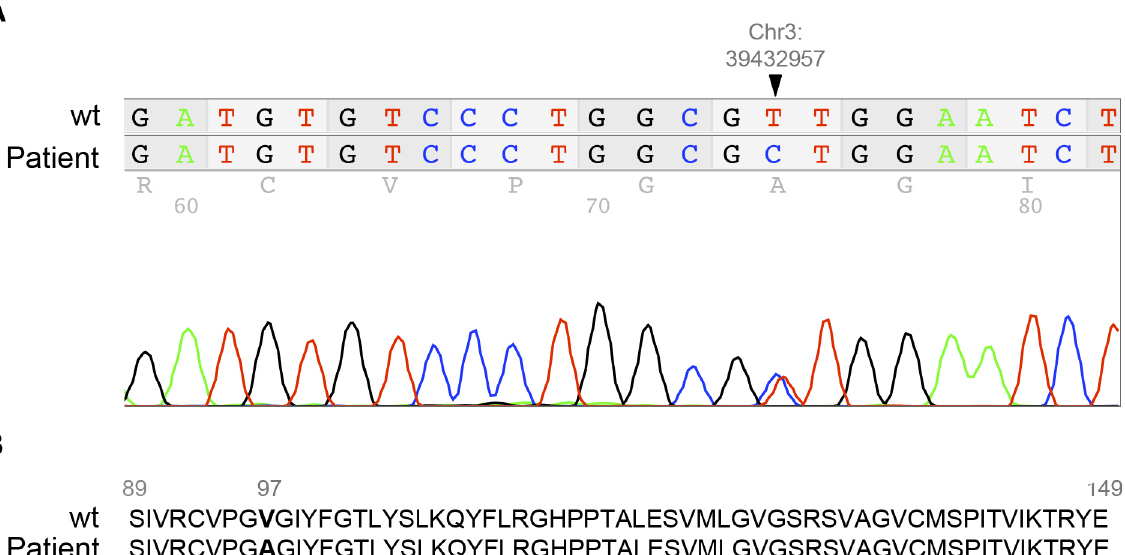
Fig 3. SLC25A38 mutation in a RCUD patient. (A) New missense mutation in exon 4 of a RCUD patient detected in BM by Sanger sequencing. The mutation is heterozygous and is located at the Chr3: 39,432,957 position. (B) Amino-acid change in the protein sequence of SLC25A38 in the RCUD patient. Valine 97 is replaced by alanine in the mutant protein. (RCUD: refractory cytopenia with unilineage